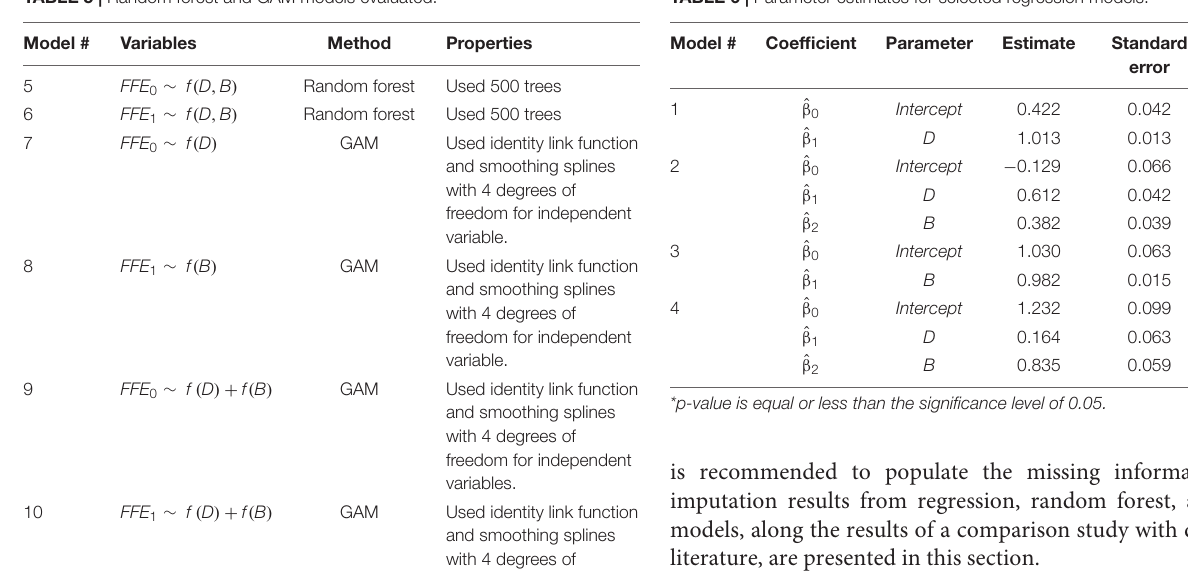
TABLE 5 | Random forest and GAM models evaluated. TABLE 6 | Parameter estimates for selected regression